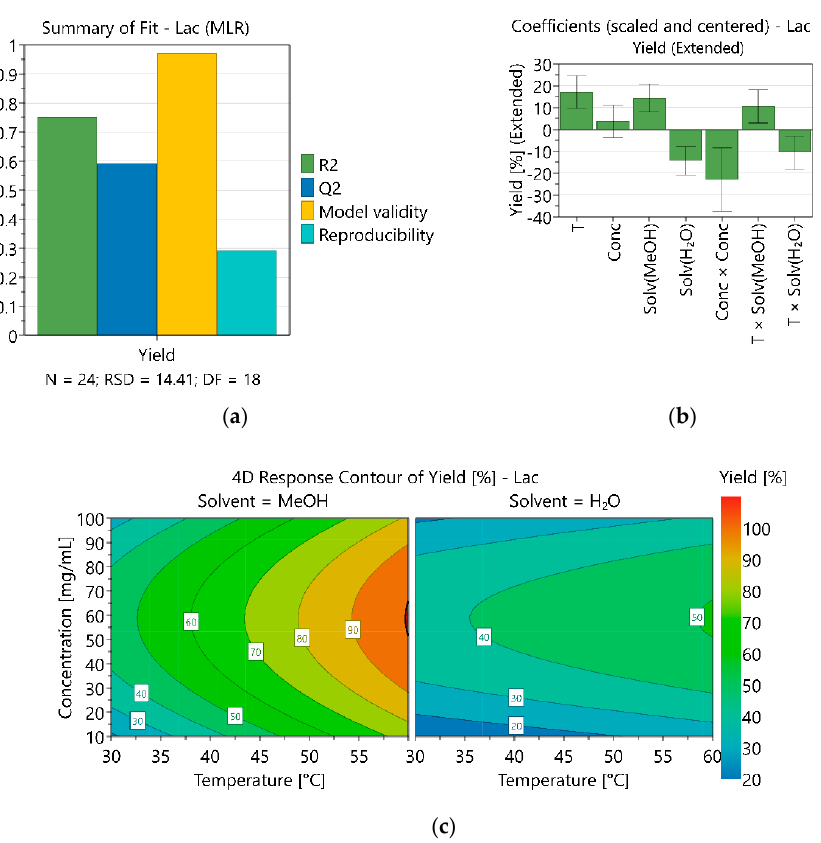
Figure 3. Plots of the model for Lac generated by MODDE: ( a ) Summary of fit represents a good model; ( b ) plot of coefficient values for scaled and centered factors shows significant factors according to the model; ( c ) the 4D response contour plot of yield predicts yields of amination in dependence on qualitative and quantitative factors.